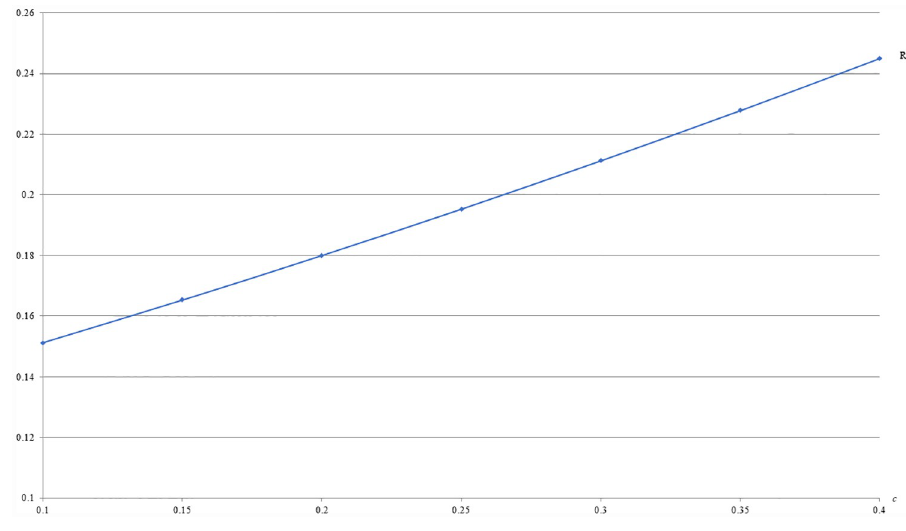
Fig 4. An illustration of the relation between revenue and c under IB.